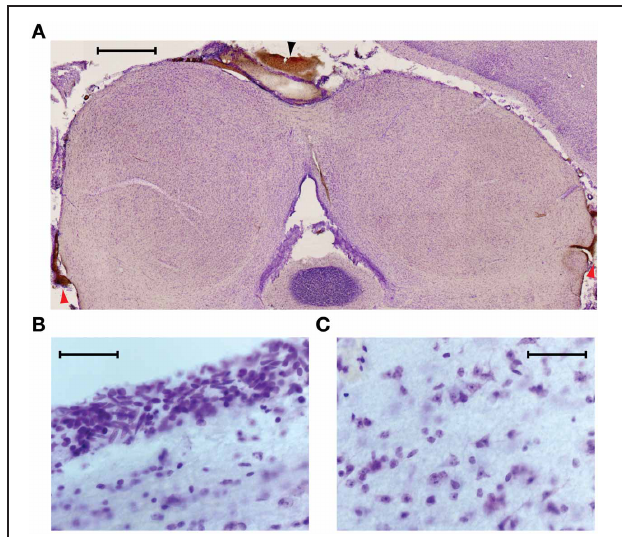
FIGURE 3 | (A) Temperature of the cryoloop (filled circles) and at 1-mm depth in the contralateral IC (open circles) during repeated cycles of cooling of different duration. The temperature in the contralateral IC falls only a few degrees below control temperature. (B) Temperature in the contralateral IC (open circles) is relatively stable as the duration of the cooling cycle is increased progressively to 30min. (C) Cooling the IC resulted in a less than 2 C reduction in temperature in the ip ◦ silateral cochlear nucleus (CN, open circles) and (D) in the ipsilateral cochlear duct (open circles).